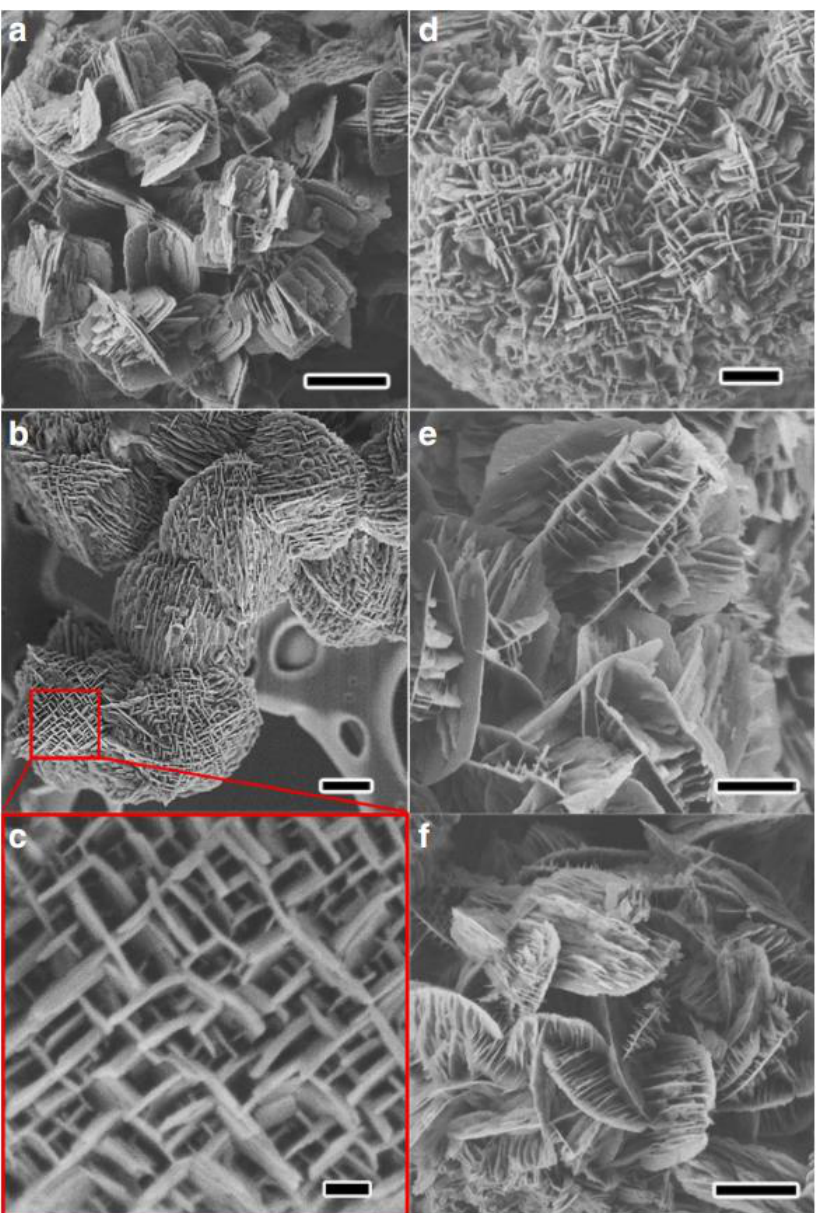
Figure 4. SEM images of as-made samples: BC Ph-4-6-6 ( a ); BC Ph-6-6-6 ( b , c ); BC Ph-8-6-6 ( d ); BC Ph-10-6-6 ( e ); and BC Ph-12-6-6 ( f ), all showing the formation of single-crystalline zeolite nanosheets with 90 °C rotational boundary. The scale bars in ( a – f ) represent 1 mm, 500 nm, 100 nm, 500 nm, 1 mm and 1 mm, respectively [42]. Copyright Nature Publishing Group, 2014.